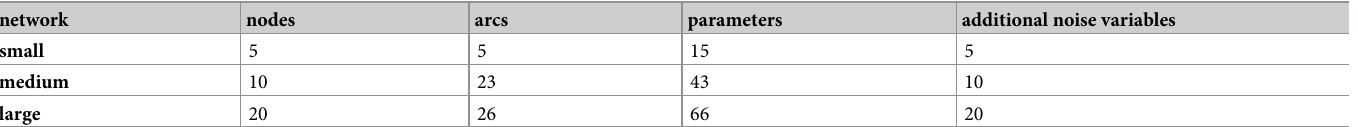
Table 5. Properties of three Bayesian network structures used for the simulation